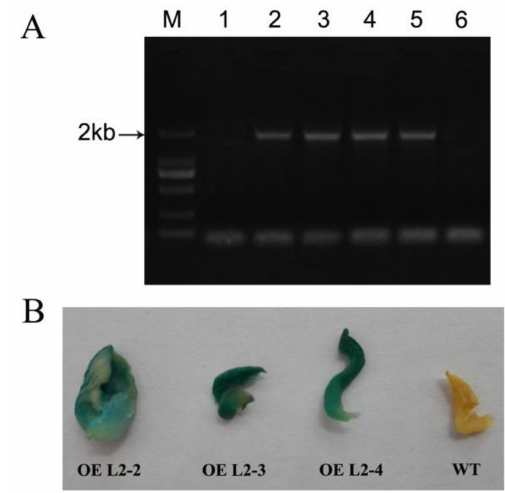
Figure 6. PCR identification and β -glucuronidase (GUS) staining of randomly selected P. ostreatus transformants and wild-types. ( A ) PCR identification of gusA gene, M: 2kb DNA marker, Lanes 1–5: ( B ) GUS staining of the wild-type (WT) and three transformed strains (OE L2-2 to OE L2-4).